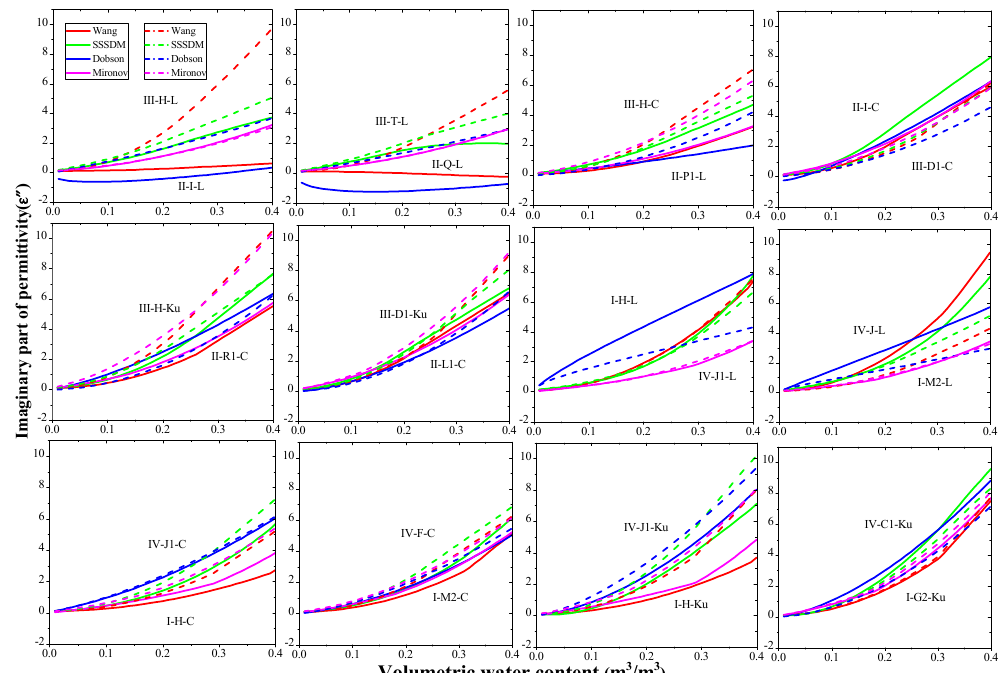
Figure 4. Simulated imaginary parts of typical soil samples for di ff erent models. A solid line is used